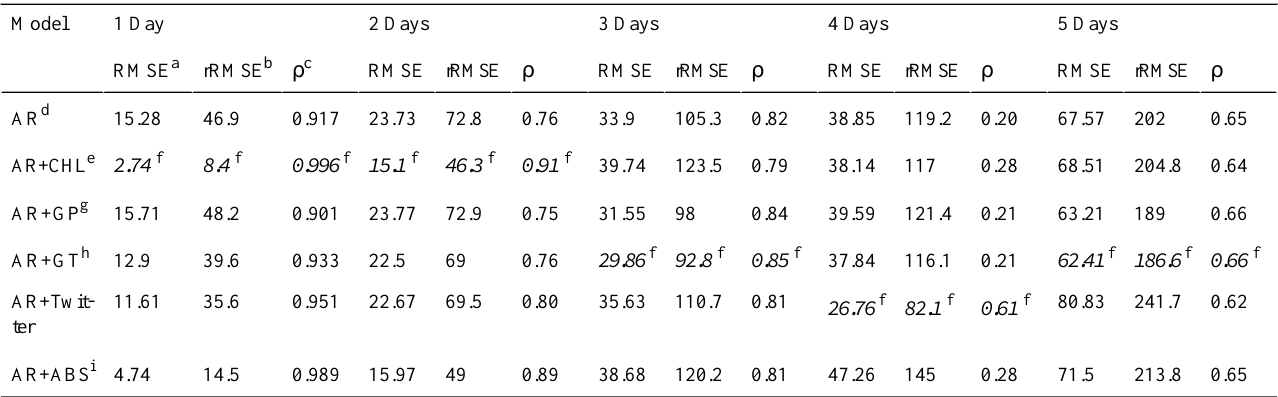
Table 4. Root mean square error, relative root mean square error, and Pearson correlation for 1-, 2-, 3-, 4-, and 5-day ahead predictions during the test period (August